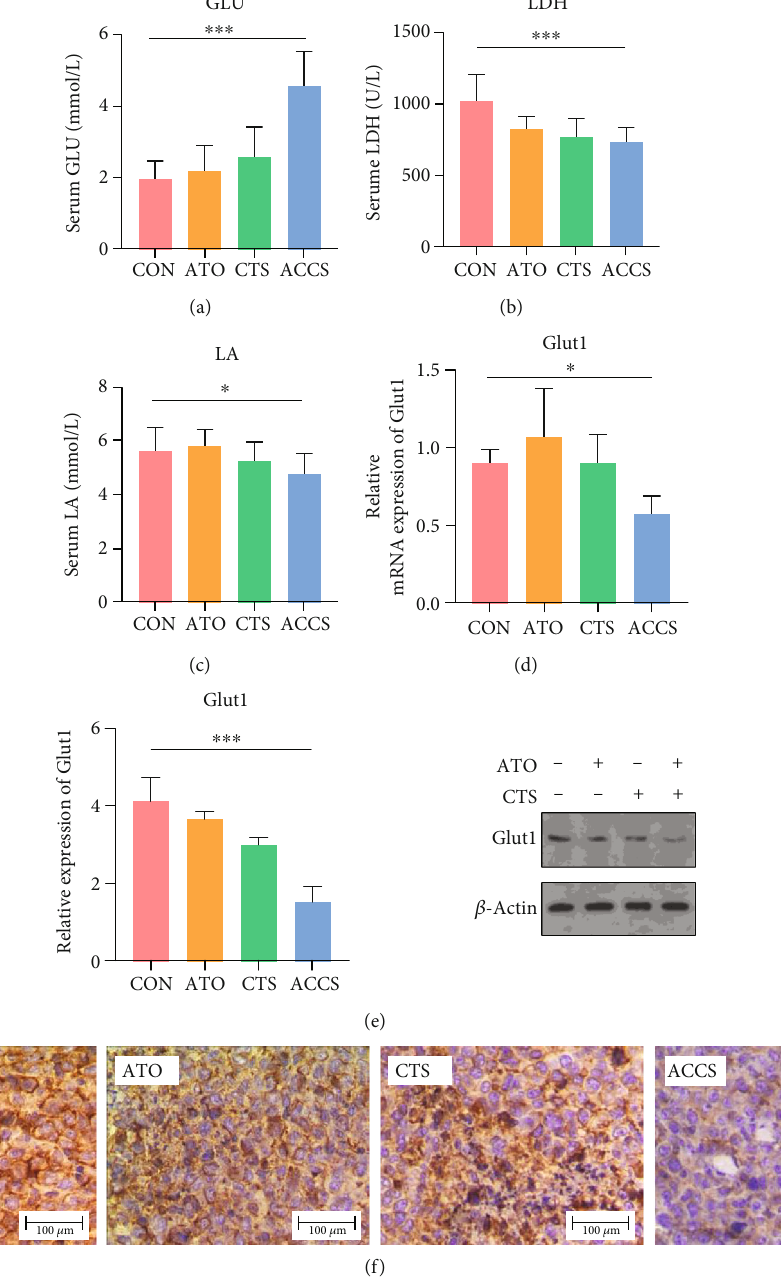
Figure 5: The e ff ect of ACCS on glycolysis in HCC mice. (a) Serum glucose level. (b) Serum lactate dehydrogenase level. (c) Serum lactic acid level. (d, e) The mRNA level and the protein level of Glut1 in tumor tissue. (f) Immunohistochemical staining of Glut1 in tumor